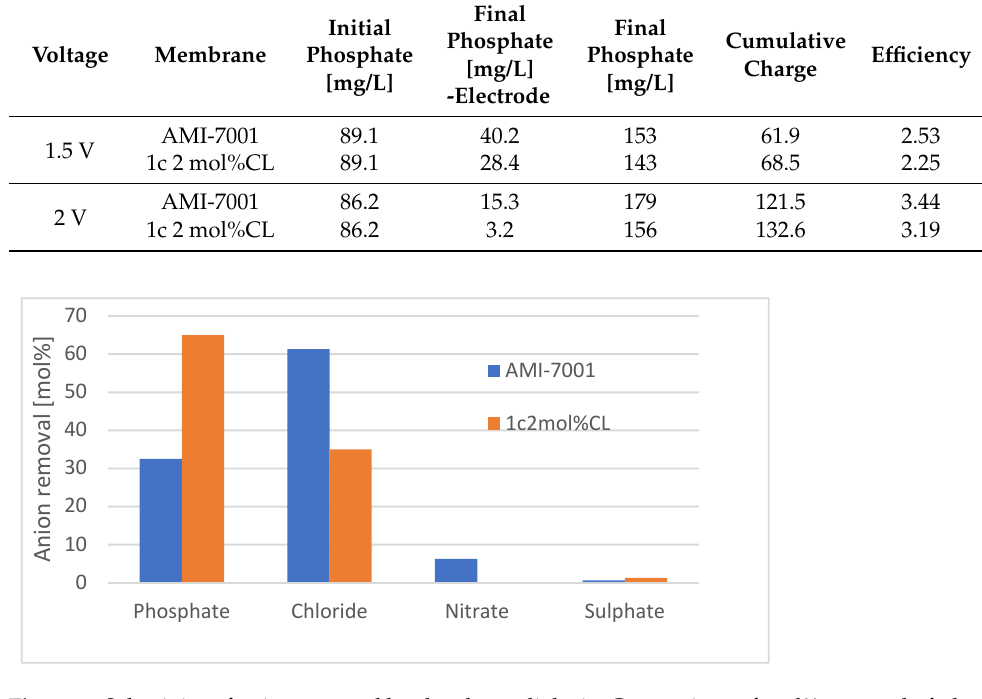
Table 3. Permselectivity measurements using 0.1 M and 0.5 M KCl solutions.